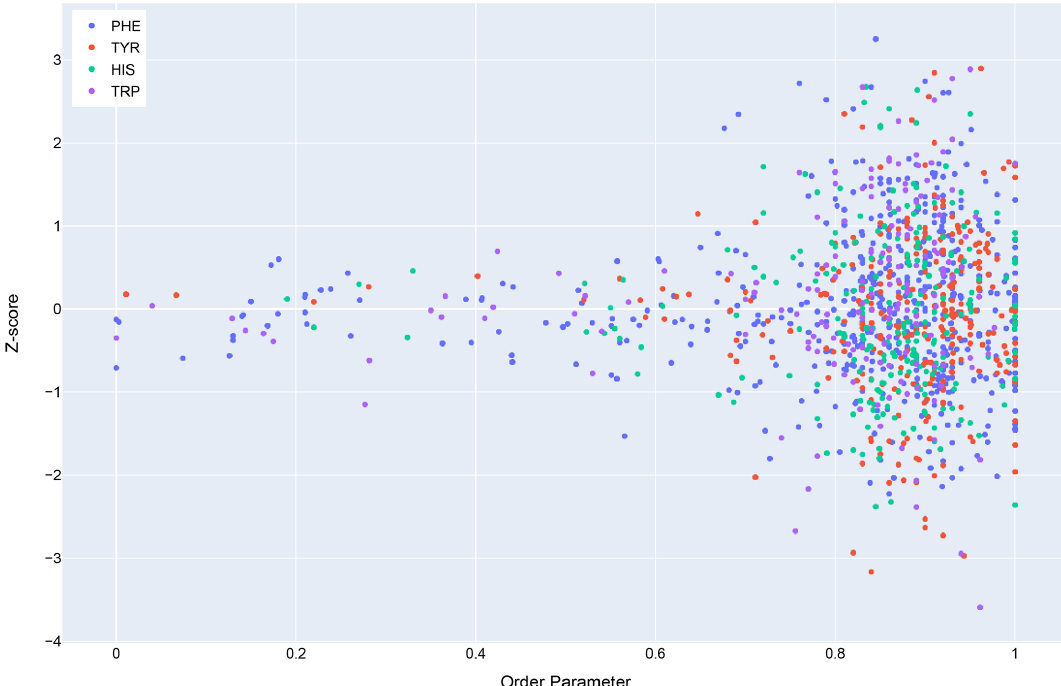
Figure 10. Correlation of Z scores with order parameters.